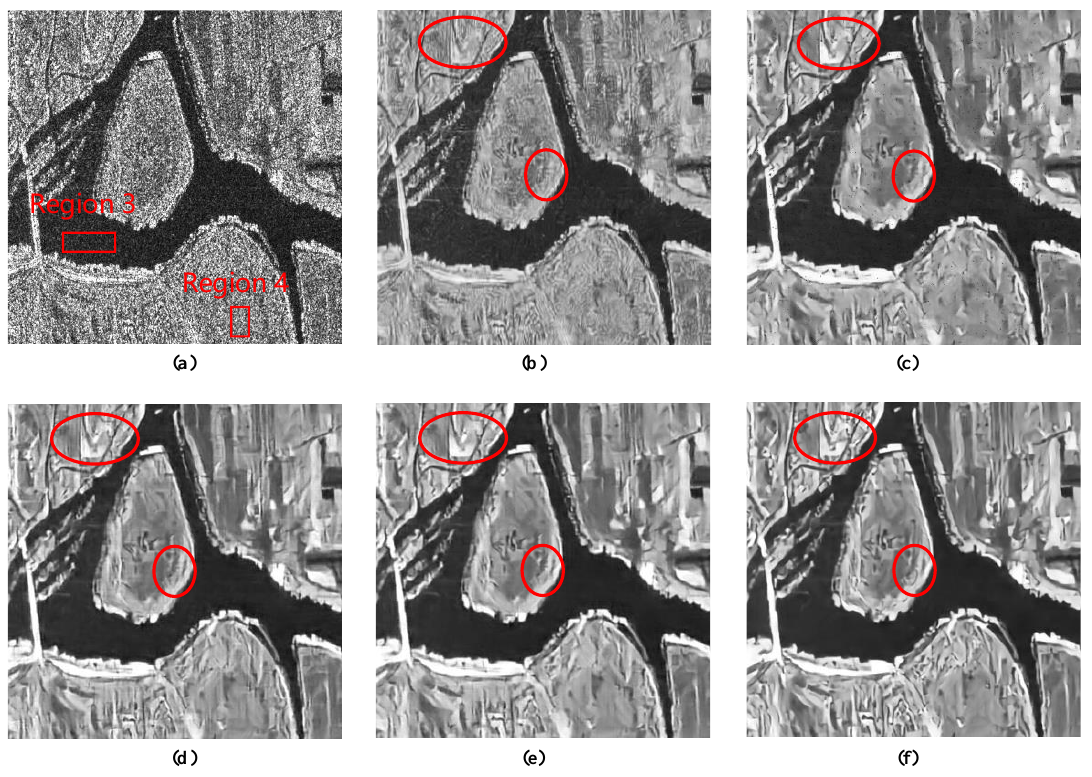
Figure 11. Test results of Real SAR images (RADARSAT-2). ( a ) Original, ( b ) SAR-BM3D, ( c ) ID-CNN, ( d ) RED-Net, ( e ) SS-net, ( f ) MSR-net. Table 5. The equivalent number of looks (ENL) of real SAR regions Data Original SAR-BM3D ID-CNN RED-Net SS-Net MSR-Net region1 3 51 317